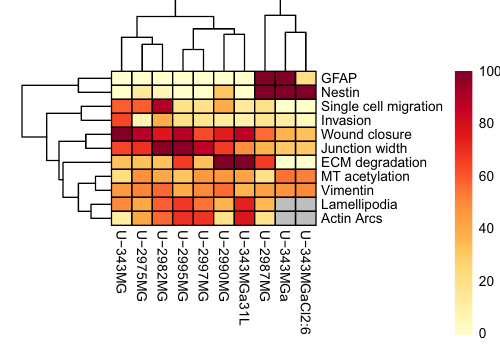
Two dimensional hierarchical clustering of cell lines vs parameters